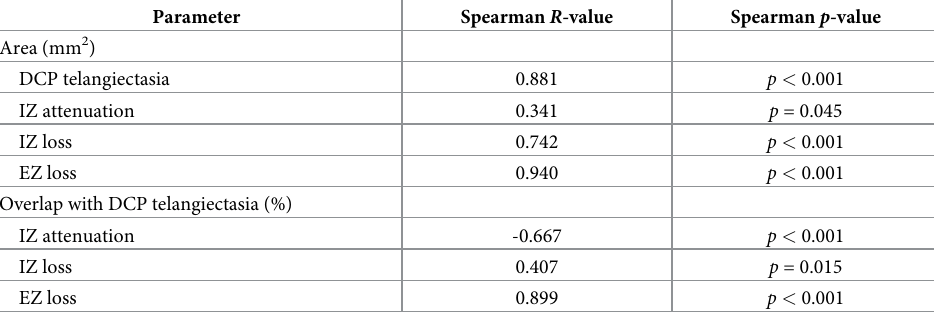
Table 2. Correlations between OCT-based MacTel stage and MacTel imaging parameters: DCP telangiectasia, photoreceptor defect areas and their overlap. Parameter Spearman R- value Spearman p